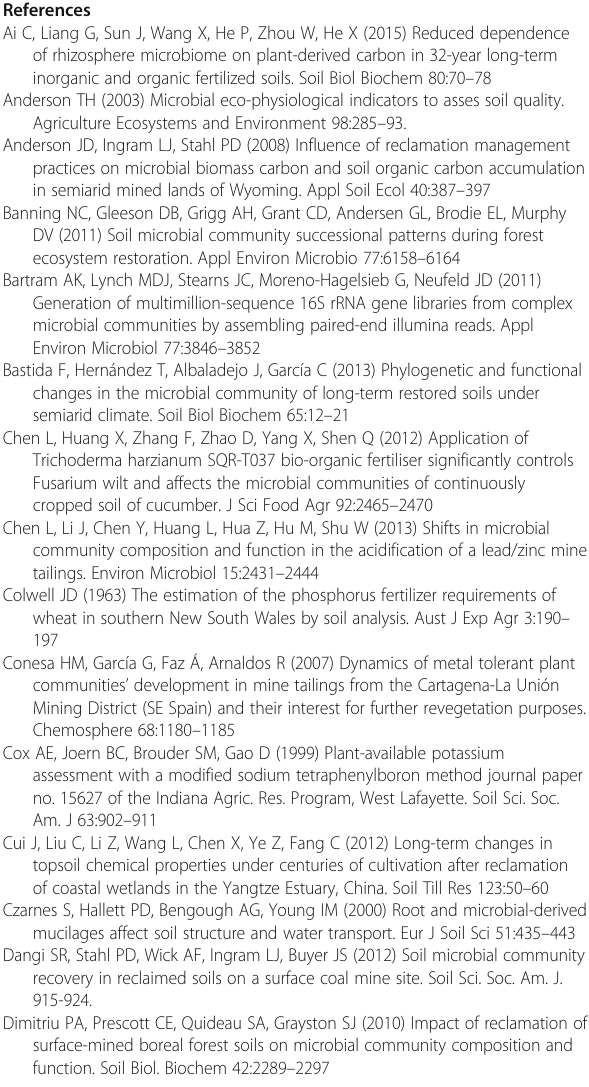
Research involving human participants and/or animals This article does not contain any studies with human participants performed by any of the